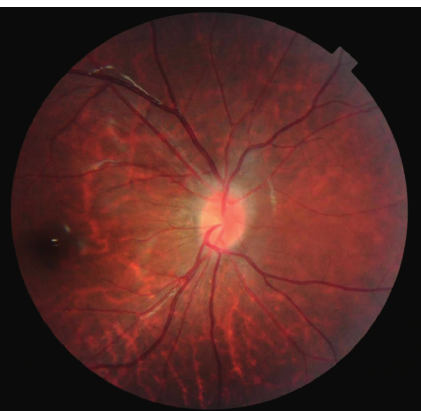
Figure 1: Fundus photography findings of a patient with ODD. Local flushing of the optic disc, congestion of the disc with dis- appearance of the fovea, and unclear boundary of the disc were observed.